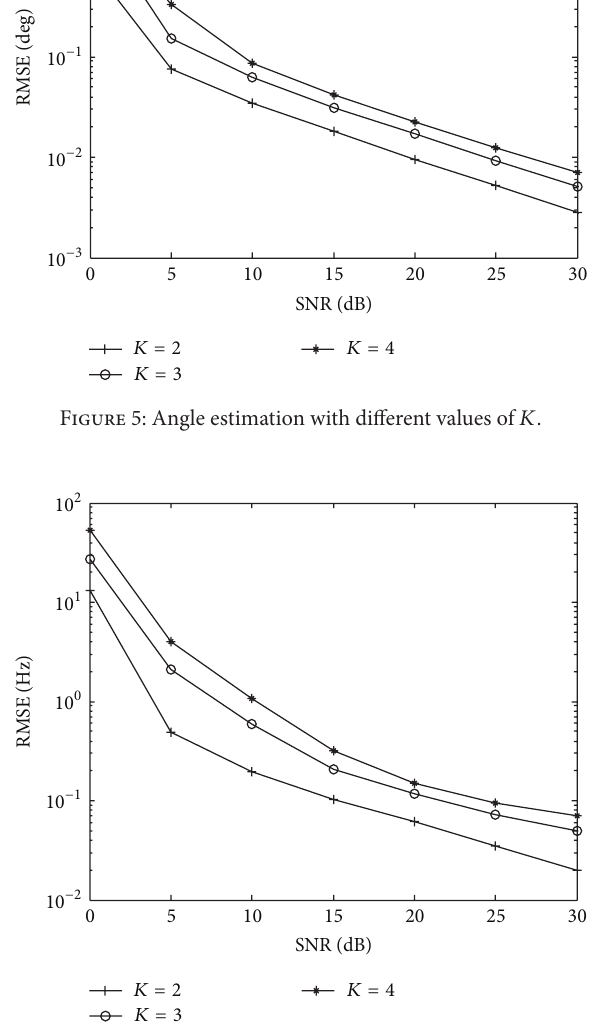
Figure 4: Doppler frequency estimation comparison.